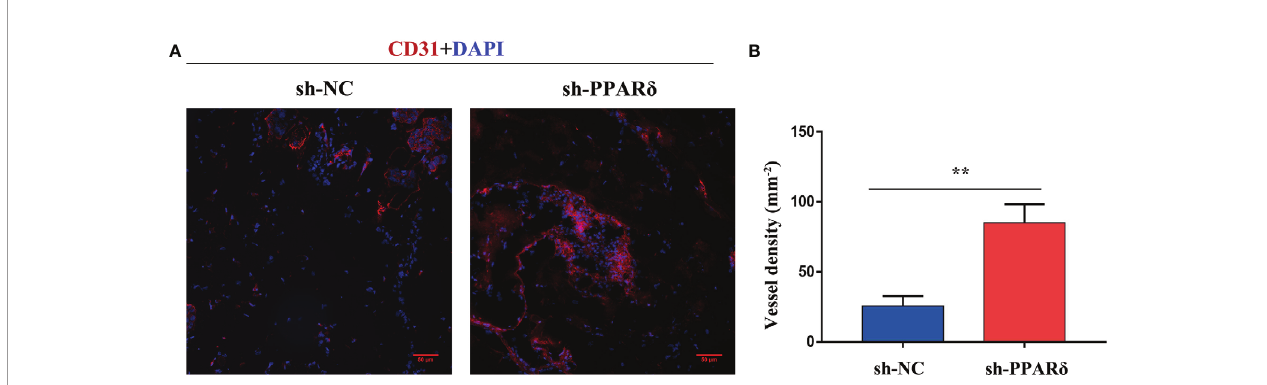
FIGURE 4 | Knockdown of PPAR d enhances angiogenesis as evaluated by a Matrigel plug assay in vivo . (A) Representative images of CD31 immuno fl uorescence staining. Cells stained with both DAPI- and CD31 represent endothelial cells. Scale bar, 50 µm. (B) Statistical summary of vessel density analysis. The density of CD31-positive cells in the PPAR d -knockdown group was signi fi cantly increased compared to the control group (k; mm 2 ; **P < 0.01; Student ’ s t-test).